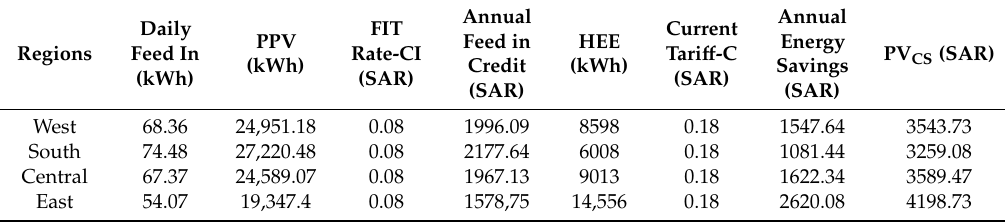
Table 12. 10 KW PV plant installation in the KSA for di ff erent regions.